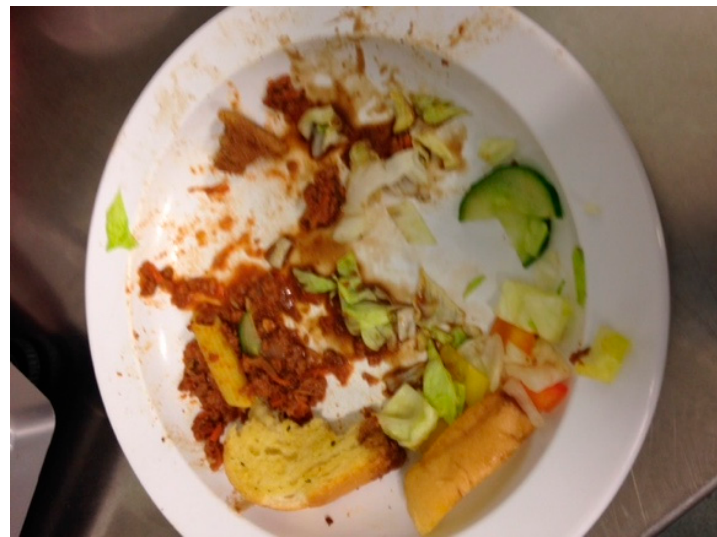
Figure 3. Example of plate waste in Study 1, with various foods mixed together (observational feeding study with preschoolers and parent reporters).